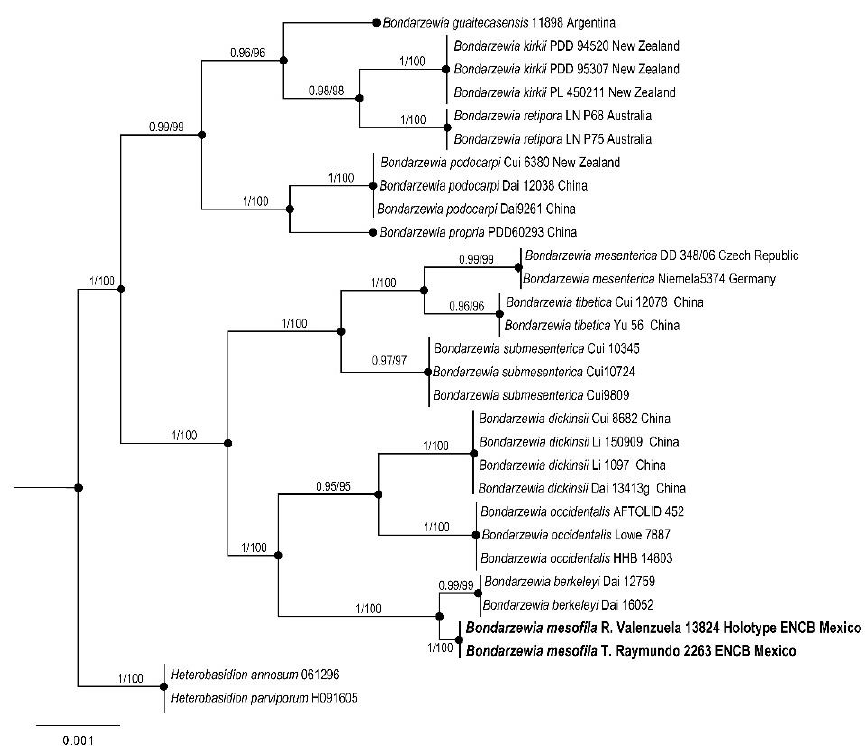
Figure 10. Bayesian inference phylogram ITS, LSU, SSU, and tef1 sequences data. Posterior probability ( left of slash) from Bayesian analysis and bootstrap support ( right of slash). The new species Bondarzewia mesofila is shown in bold. Boldface names represent samples sequenced for this study.